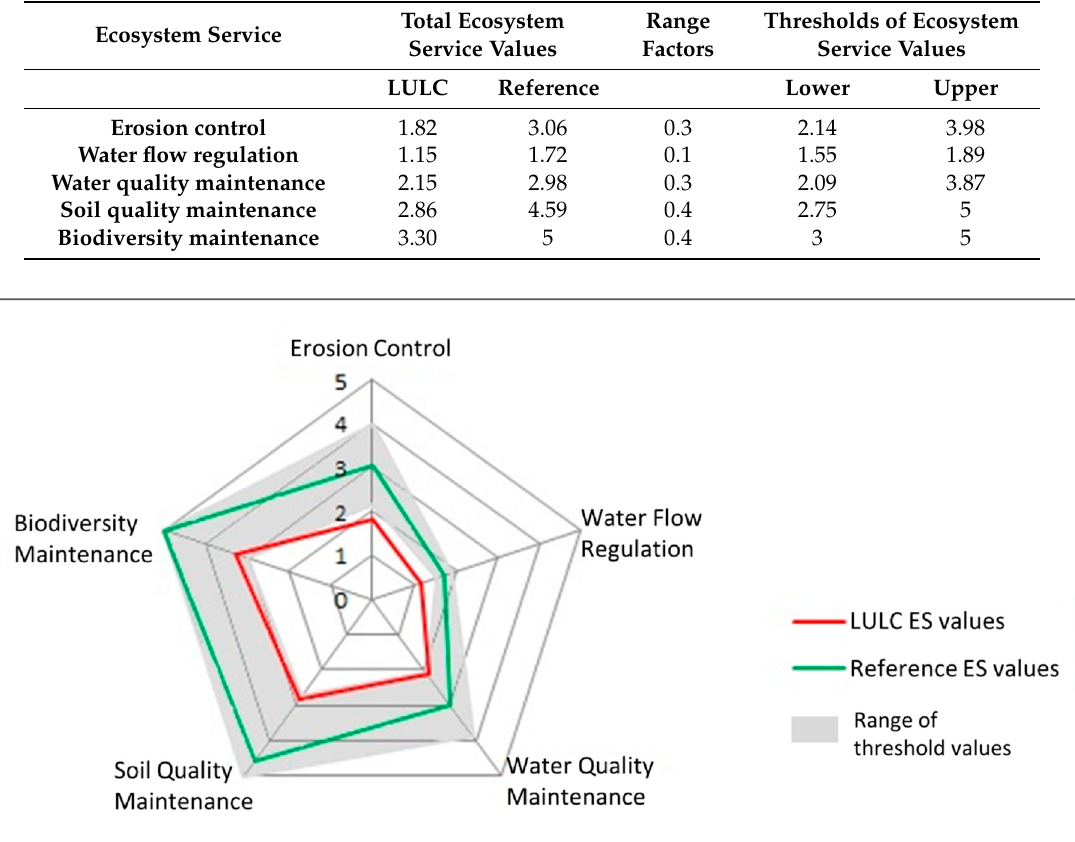
Figure 6. Visualization of the total ecosystem service values for the LULC and reference situations and the range of threshold values for the reference situation with lower and upper threshold values for each ecosystem service.